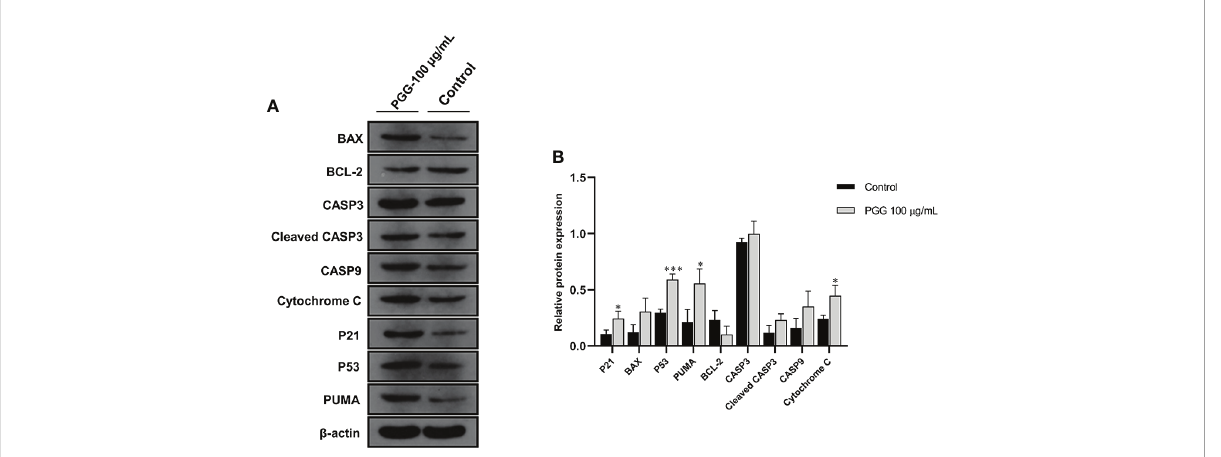
FIGURE 11 The expression levels of apoptosis-related proteins in SGC7901 cells. (A) The expression levels of BAX, BCL-2, CASP3, Cleaved CASP3, CASP9, Cytochrome C, P21, P53, and PUMA in SGC7901 cells as determined by Western blot. Cells were treated with 100 µg/ml of 1,2,3,4,6- pentagalloyl- b -D-glucose for 24 h (B) The average band grayscale of P21, BAX, P53, PUMA, BCL-2, PUMA, CASP3, Cleaved CASP3, CASP9, and Cytochrome C proteins. Cells were treated with 100 µg/ml of 1,2,3,4,6-pentagalloyl- b -D-glucose for 24 h * p < 0.05, *** p < 0.001 vs.